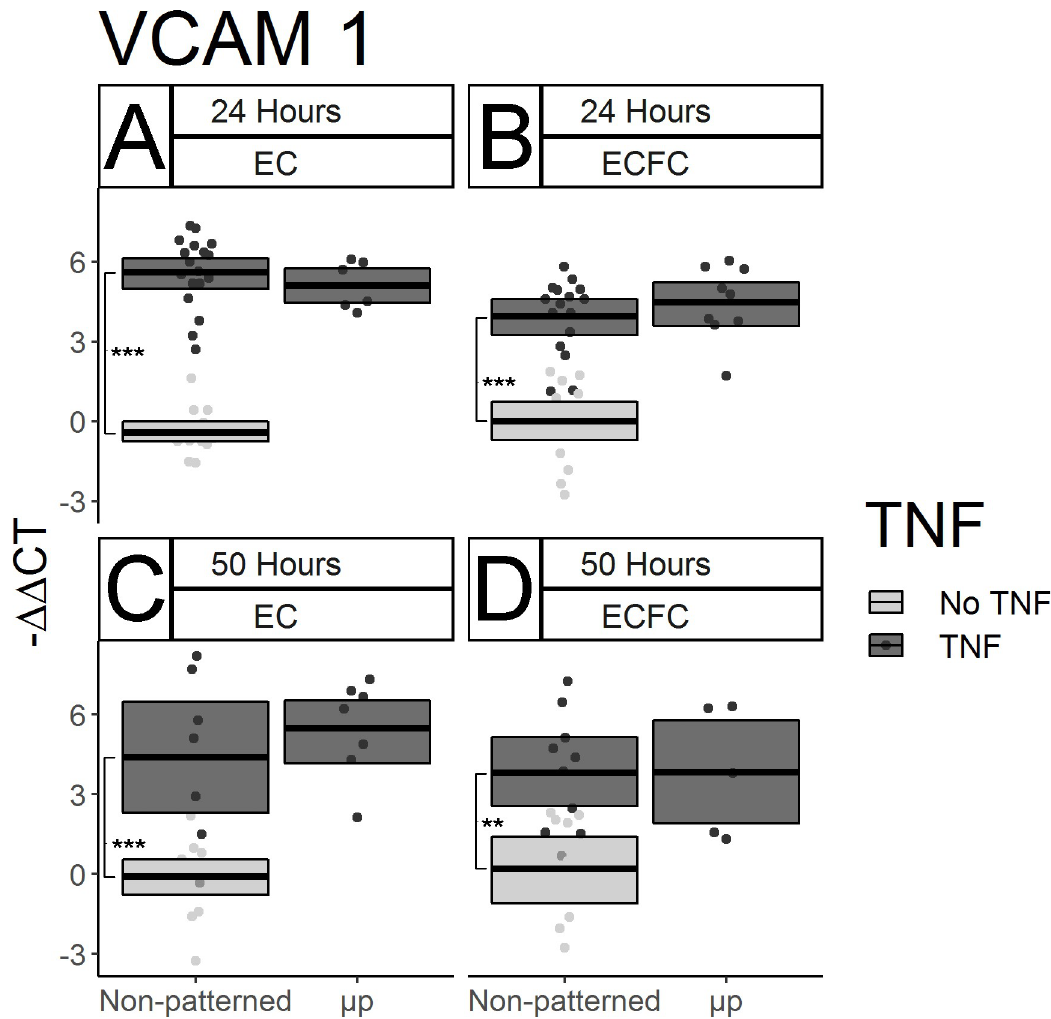
Fig 6. Micropatterning has no discernible effect on inflammatory molecule gene expression in ECs or ECFCs. VCAM-1 gene expression was measured by qPCR in ECs and ECFCs after 24 and 50 hours of culture. Data are displayed as– ΔΔ CT. TNF- α was added for the final two hours of culture. Box limits represent bootstrapped 95% confidence intervals and crossbars represent means. Each point represents one biological replicate. Light gray boxes and points represent gene expression for non-patterned, non-TNF treated cells in each cell type and time point. TNF- α efficacy at stimulating increased VCAM-1 gene expression was confirmed in each cell type at both time points. (A) ECs after 24 hours (p < 0.0001). (B) ECFCs after 24 hours (p < 0.0001). (C) ECs after 50 hours (p < 0.0001). (D) ECFCs after 50 hours (p = 0.0003). No micropatterning-dependent difference in TNF- α stimulated VCAM-1 expression was seen in either cell type at either time